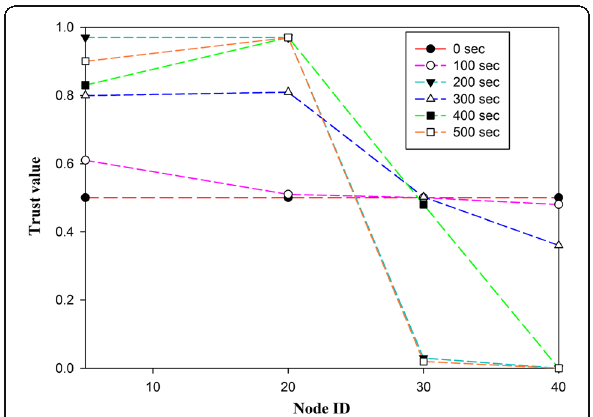
Figure 7: direct trust for different nodes shows the direct trust calculated for random node 5, 20, 30 and 40 at a maximum time period of 500 s. From the figure, it is clearly shown that the nodes 30 and 40 misbehaved and so the trust value that is calculated directly by observing node 30 and 40 is gradually decreased to zero, whereas the other two nodes show an increased trust level with their trustworthy behaviour. The indirect trust for nodes 5, 20, 30 and 40 are calculated and plotted in Fig. 8: indirect trust for different nodes with a simulation time set at 300 s. The trust value for nodes 5 and 10 is greater than 0.5, which show higher node cooperation for trust value. On the other hand, the indirect trust of nodes 30 and 40 degrades below 0.5 due to misbehaviour observed using the Bayesian-Evidence